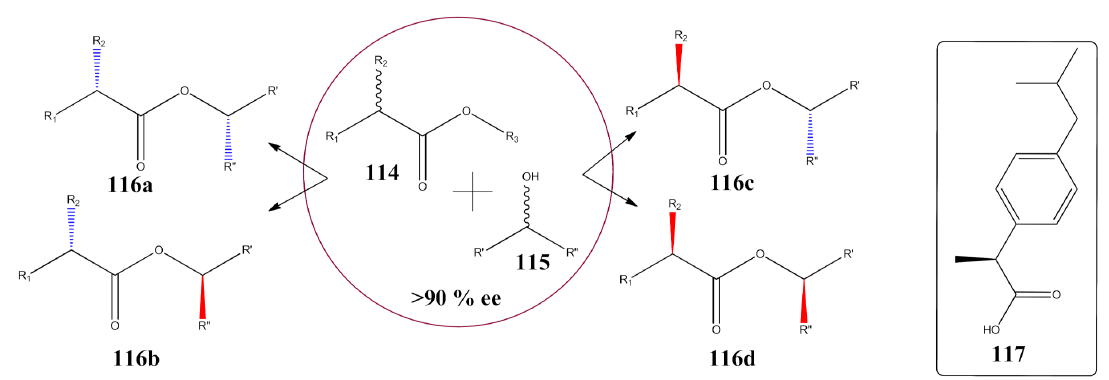
Scheme 29. Lipase engineered through FRISM showing switchable